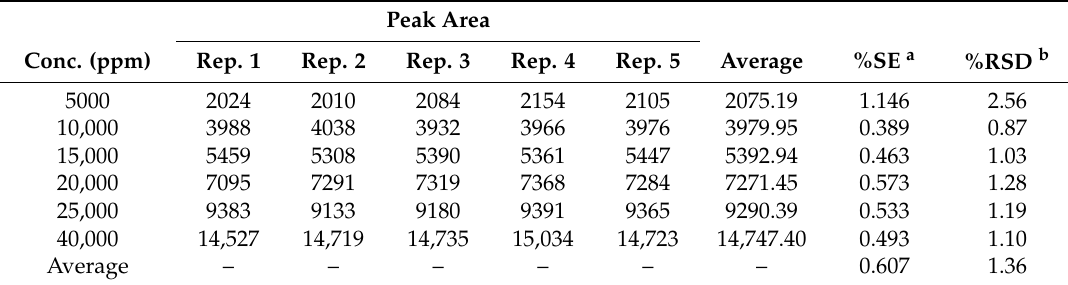
Table 5. Response of the instrument to different concentrations of ethanedinitrile to determine linearity and precision of the analytical method. Peak